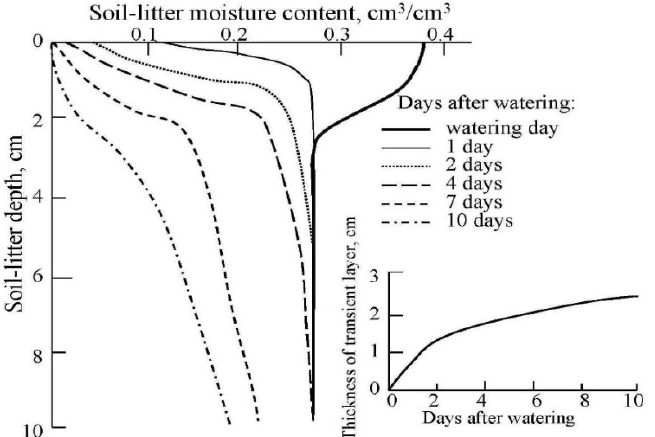
Figure 9. Experimental soil-litter moisture profiles in soil-litter drying dynamics. The depth of the